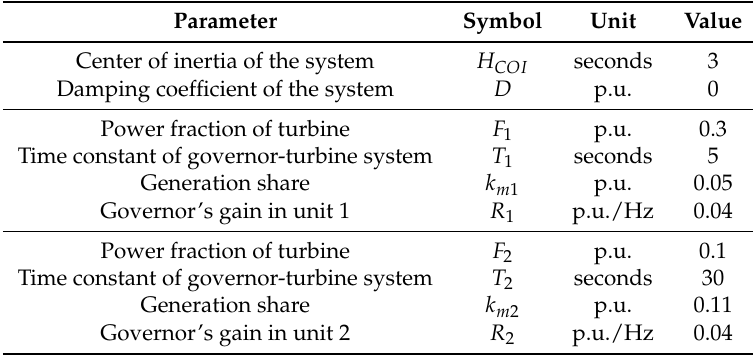
Table 1. SFR model’s parameters of the system under